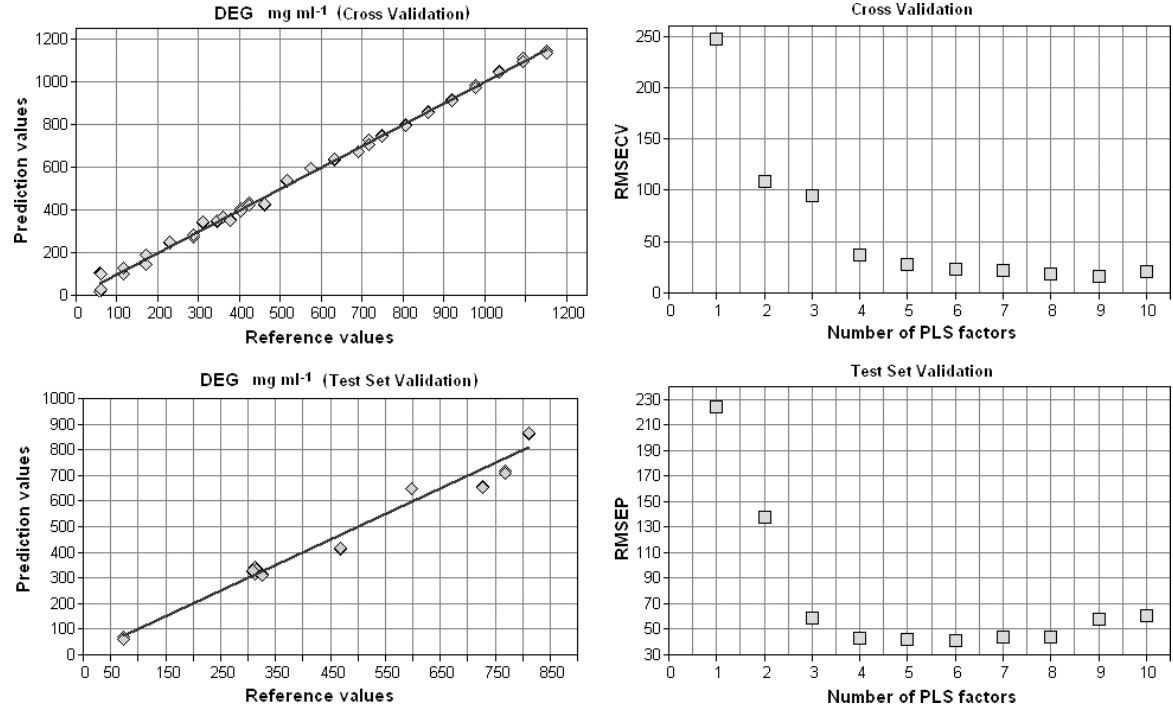
Fig. 6. Validation results of the calibration model for the preparations containing